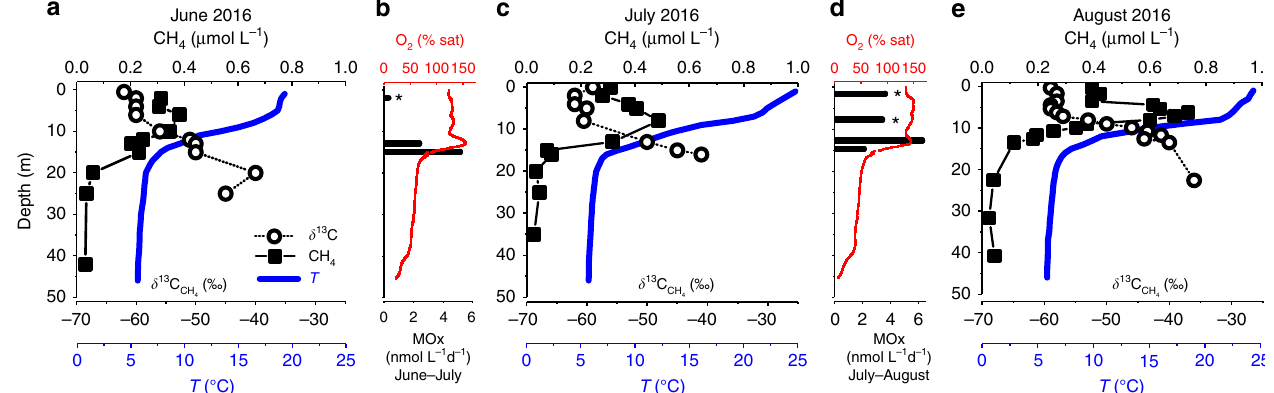
Fig. 4 Water column CH 4 concentration and oxidation rates. a , c , e Water column pro fi les of CH 4 , δ 13 C CH4 , and temperature for 17 June, 7 July, and 3 August 2016. CH 4 pro fi les show the distinctive metalimnetic maxima, while at 25 – 30 m concentrations were < 0.05 µ mol L − 1 . The δ 13 C CH4 pro fi les in the epilimnion are rather uniform with values around − 62 to − 60 ‰ . b , d Average dissolved oxygen pro fi les and MOx rates obtained from in situ incubations for the periods June – July 2016 and July – August 2016 show maximum oxidation rates and correspondingly higher δ 13 C CH4 values at 15 and 13 m depth, respectively. In the SML, oxidation rates were negligible for the period June – July 2016, and higher during the period July – August 2016 (3.6 ± 0.2 nmol L − 1 d − 1 ) although associated with no signi fi cant (2 ‰ ) change in δ 13 C CH4